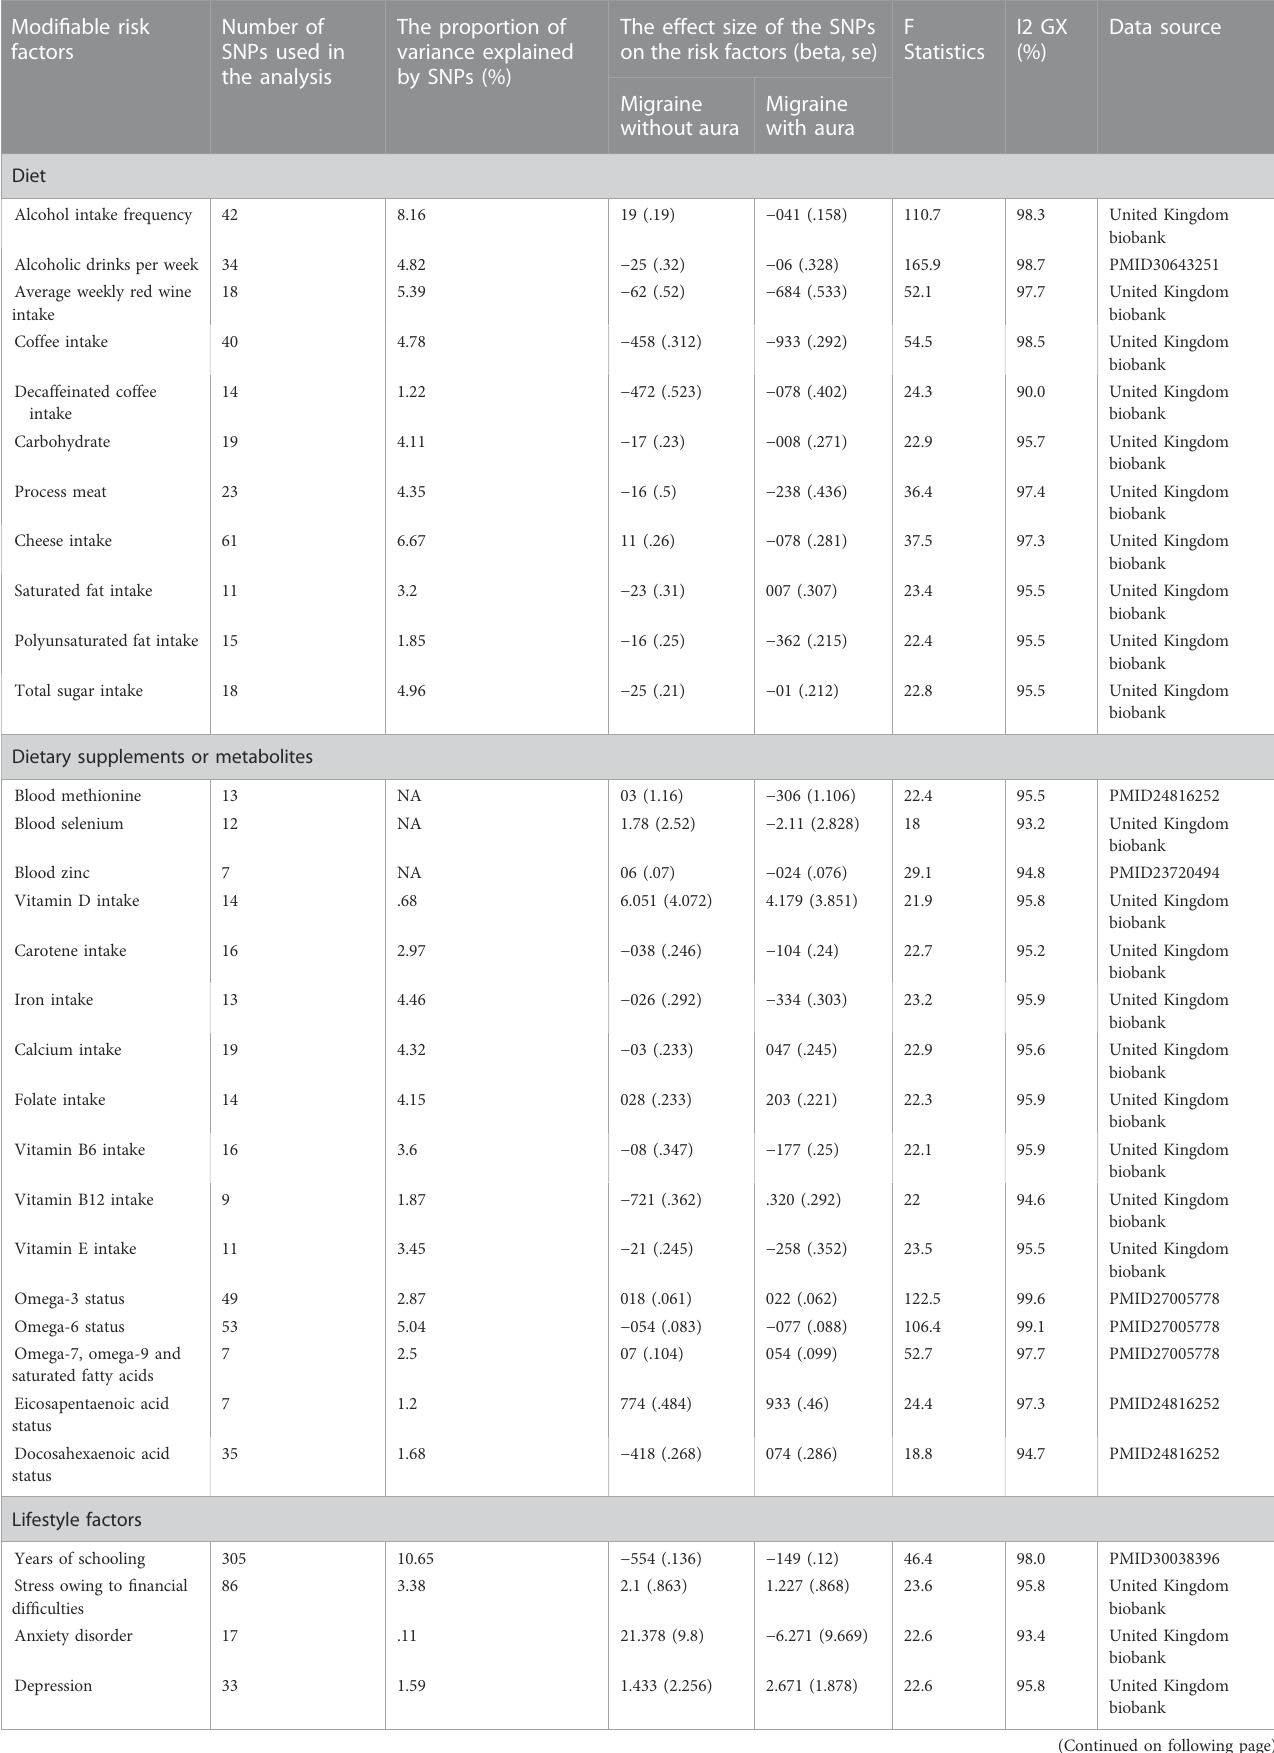
TABLE 1 Summary of modi fi able risk factors for migraine in the Mendelian randomization